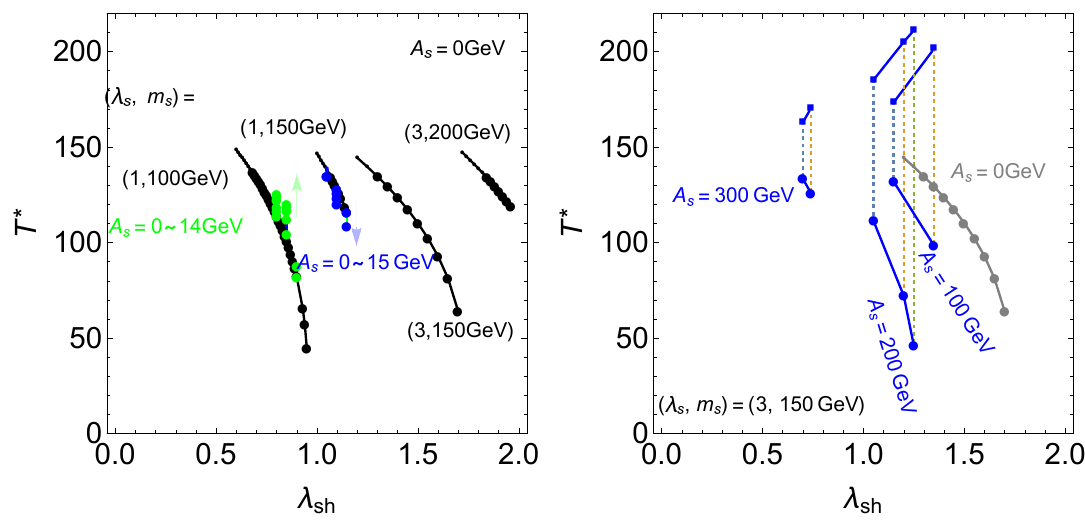
Figure 7 . First order phase transition temperature as the function of (cid:21) sh for the two-step PT ((cid:10) 0 ! (cid:10) s ! (cid:10) h ) in the (cid:17) > 0 region. For the second-(cid:12)rst order PT pattern (left panel), we show the Z 2 -like case with A s = 0 GeV (black lines) and the deviations from non-zero A s by (cid:12)xing (cid:21) sh (green and blue lines), for four cases ( (cid:21) s ; m s [GeV]) = (1 ; 100) ; (1 ; 150) ; (3 ; 100) ; (3 ; 150). The (cid:12)rst-(cid:12)rst order PT pattern (right panel) arises in the larger (cid:21) s region which allows a larger A s ; for ( (cid:21) s ; m s [GeV]) = (3 ; 150), we show A s [GeV] = 100 ; 200 ; 300 (blue lines). For each dashed line, the upper and the lower ends denote T (cid:3) and T (cid:3) , respectively. In these plots we just keep the points s h which give